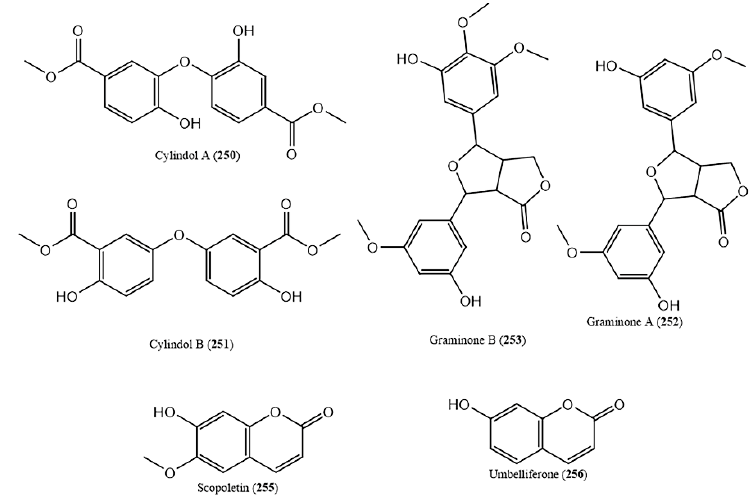
Figure 8. Some polyphenols reported in halophytic grasses.